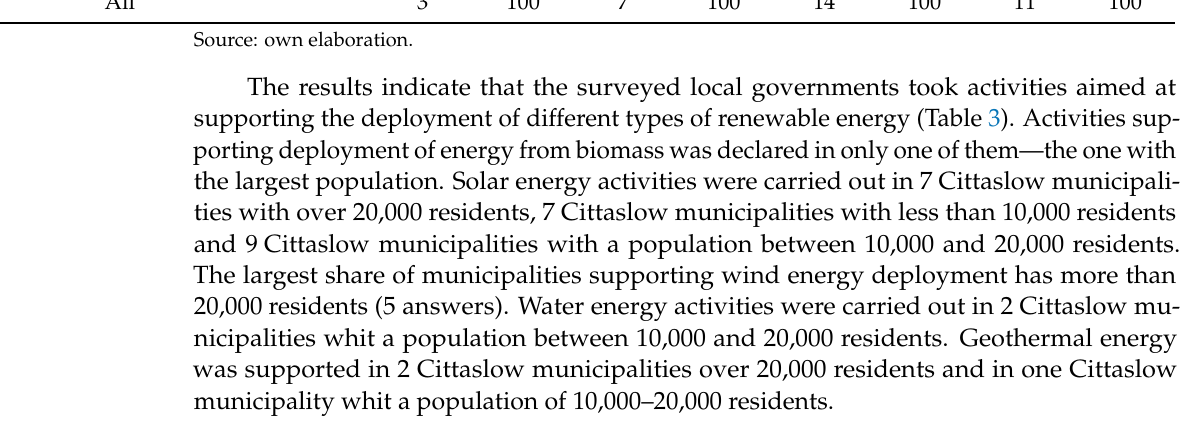
Table 3. Types of supported renewable energy by categories of Cittaslow municipalities.